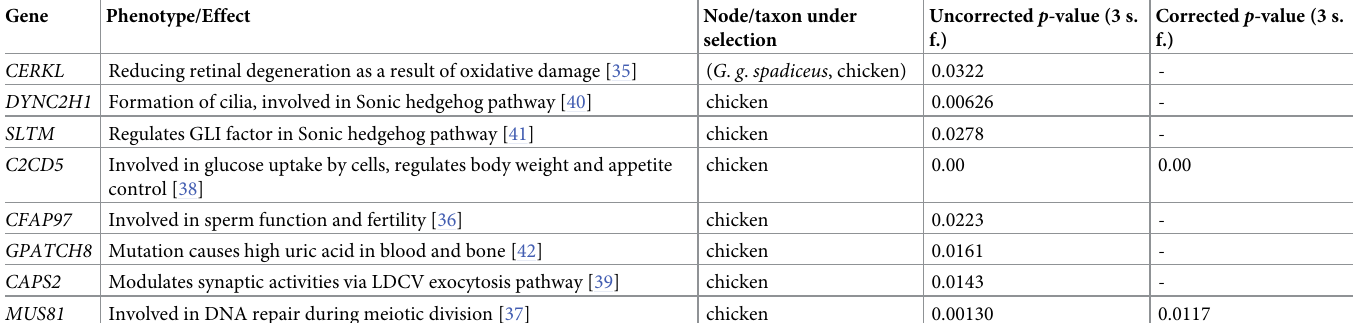
Table 1. Function of genes located on genomic islands of high differentiation between chickens and junglefowl which are under selection in chickens. Only CERKL was found to be under selection in both chickens and wild spadiceus ; the remainder were found to be under selection uniquely in chickens. Values are rounded to 3 signifi- cant figures